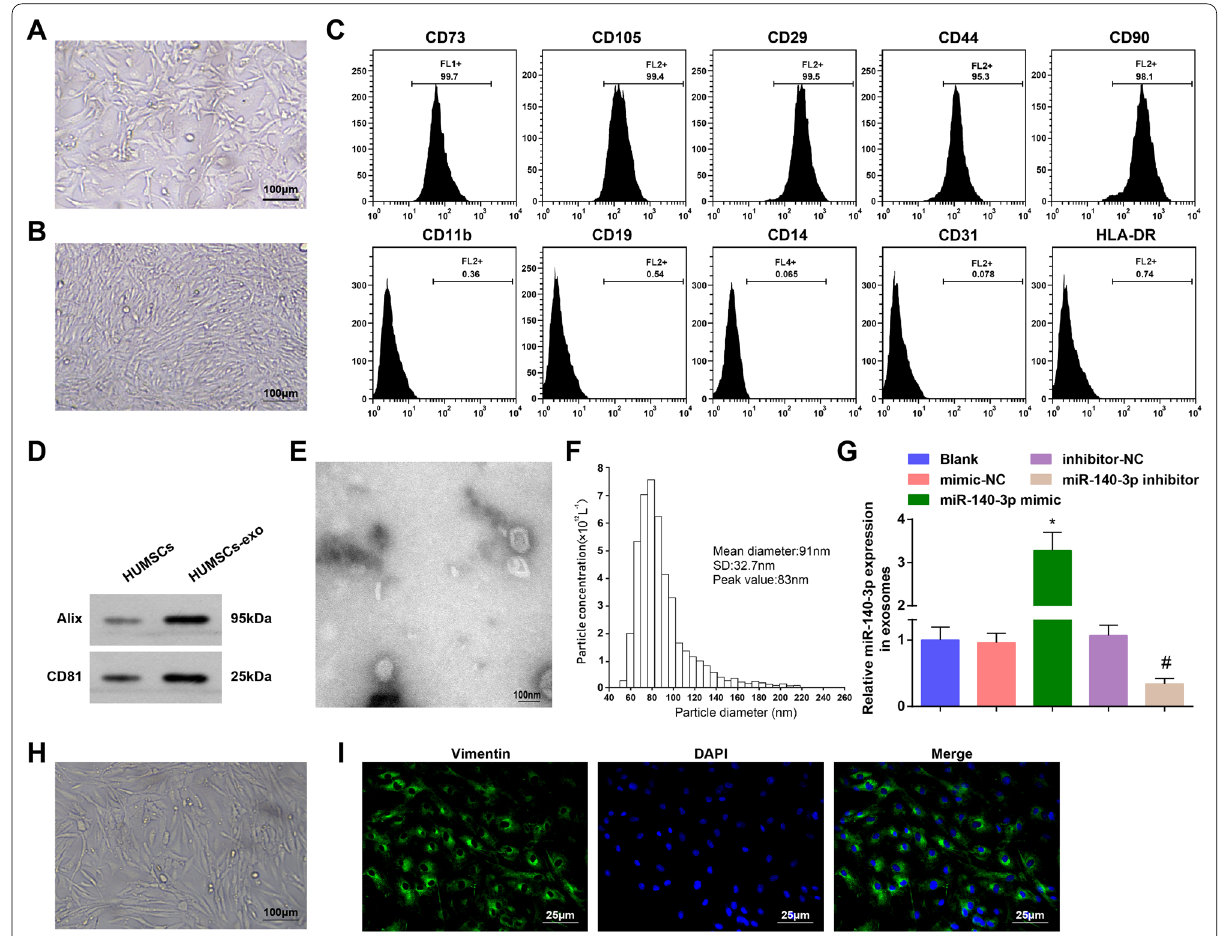
Fig. 1 Identification of HUCMSCs, HUCMSCs-exo and RASFs. A Morphological observation of low density HUMSCs; B Morphological observation of high density HUMSCs ; C Surface antigens of HUMSCs were detected by flow cytometry; D Expression of CD81 and Alix in exosomes was determined by Western blot analysis; E Exosomes were identified through a TEM; F Particle size of exosomes was analyzed by NTA; G Expression of exosomal miR-140-3p was assessed by RT-qPCR; H Morphological observation of rat RASFs ; I Rat RASFs were identified by vimentin protein immunofluorescent staining; N 3; * P < 0.05 vs the mimic-NC group, # P < 0.05 vs the inhibitor-NC group; the data were expressed as = mean standard deviation, ANOVA was used for comparisons among multiple groups and Tukey’s post hoc test was used for pairwise comparisons ± after